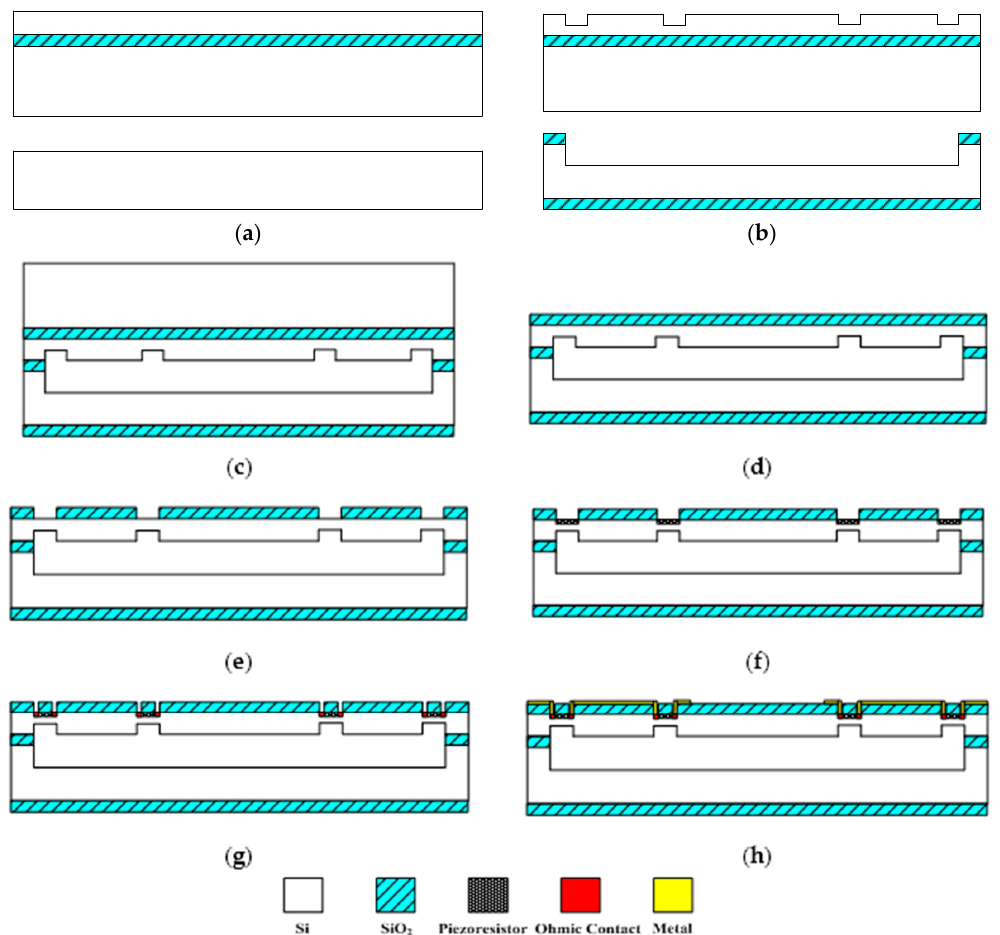
Figure 9. Process flow diagram: ( a ) preparing wafers; ( b ) RIE etching; ( c ) bonding; ( d ) TMAH etching; ( e ) etching; ( f ) implanting boron; ( g ) implanting denser boron; ( h ) sputtering and releasing.